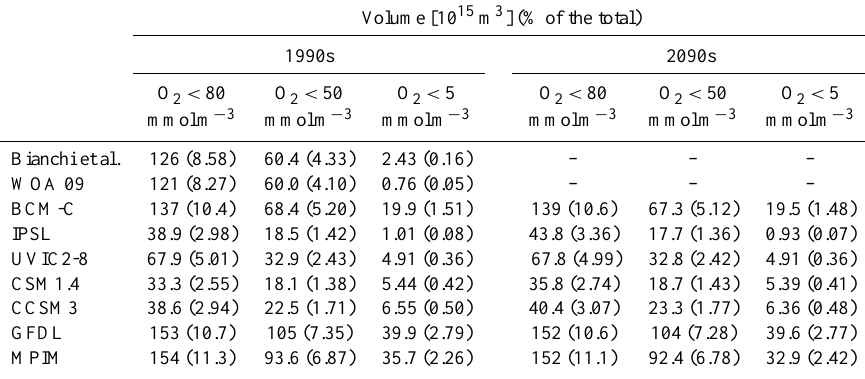
Table 1. Observed and modeled present-day and 2090s (decadal average) volume of three water classes identified by different O 2 regimes, expressed in m 3 and in percent of the total oceanic volume. In the first line, the revised WOA 05 values from Bianchi et al. (2012) are listed.